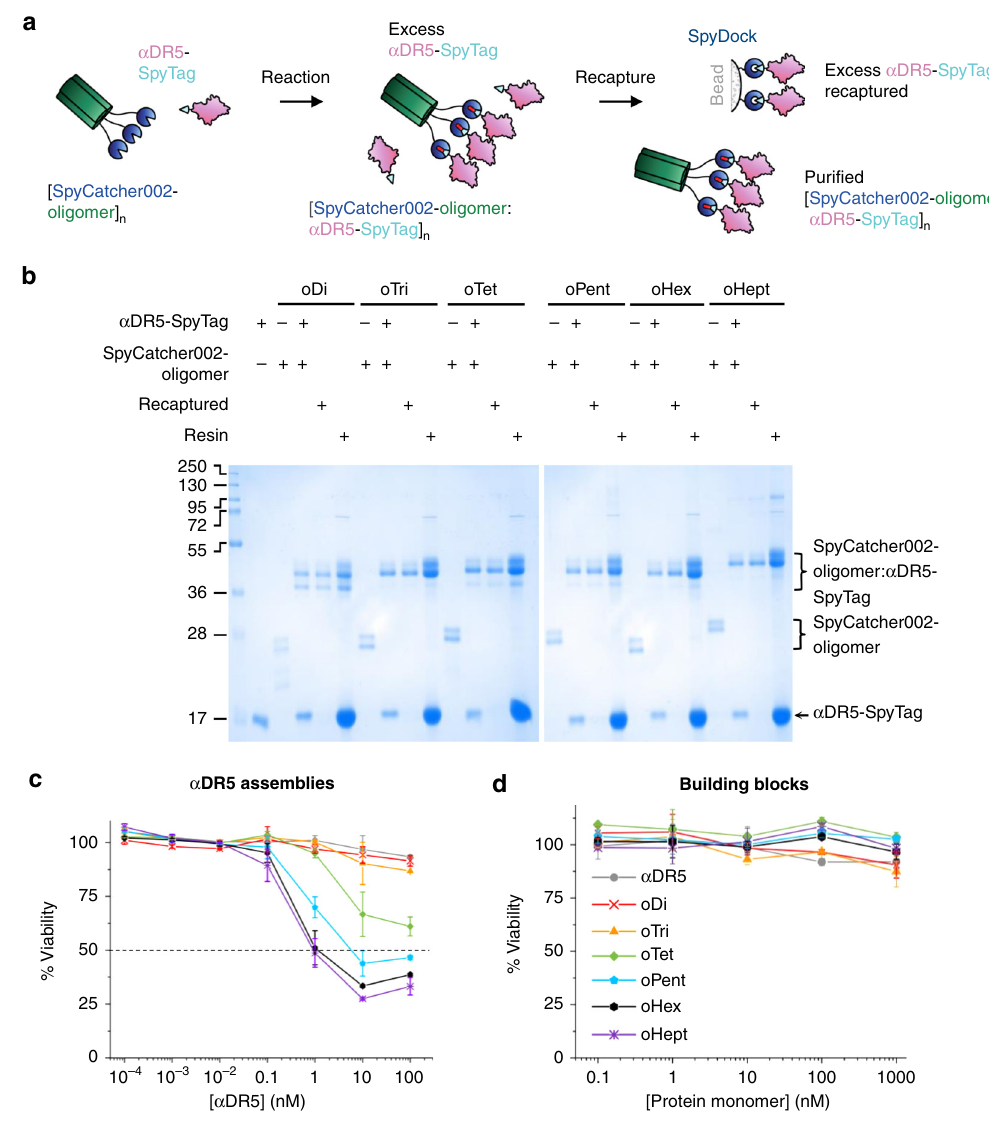
Fig. 7 Oligomer panel tested for cancer cell killing. a Cartoon depicting depletion of free SpyTag-ligand using Spy&Go resin. b Coupling of SpyTag-fusion to coiled coil series. α DR5-SpyTag was incubated with each SpyCatcher002-coiled coil and analyzed by SDS-PAGE with Coomassie staining. In Recaptured lanes, excess α DR5-SpyTag was removed from the coiled coil conjugate by an additional passage through Spy&Go resin. c Dose-response curve of MDA- MB-231 cell viability when treated with different concentrations of α DR5 conjugated to each SpyCatcher002-oligomer platforms. The line at 50% cell viability shows the cut-off for EC 50 calculation. The x -axis is normalized to the concentration of α DR5 monomer. Error bars represent mean ±1 s.d., n = 2. d MDA-MB-231 viability upon incubation as in c with the building blocks of α DR5 alone or coiled coils alone. Error bars represent mean ± 1 s.d., n =